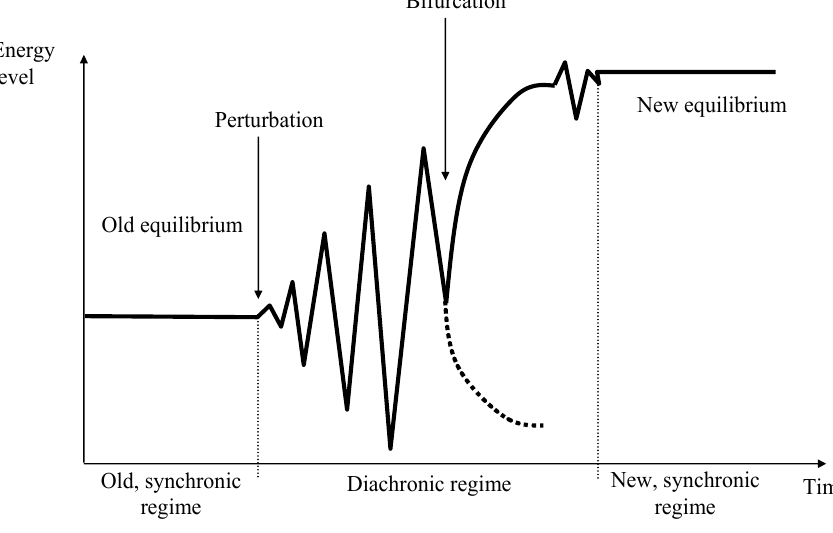
Figure 2. Transformation into a new systems regime. Source own, based on [13].